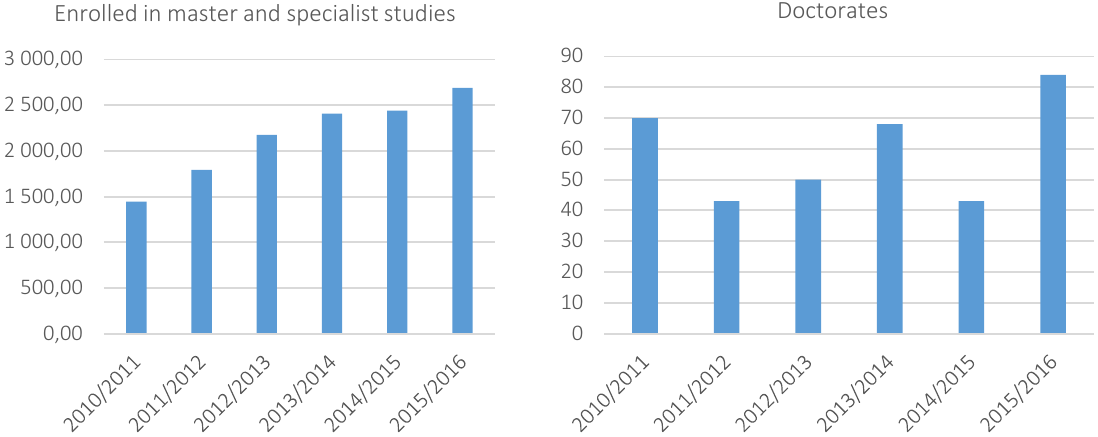
Figure 7. Enrolled in masters and specialist studies and doctoral studies